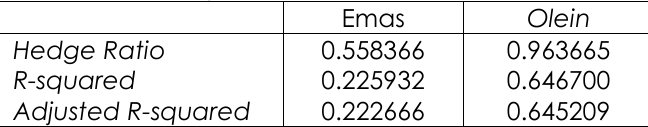
Tabel 4.1 menunjukkan rasio hedge dari emas lebih kecil dari rasio hedge emas, hal